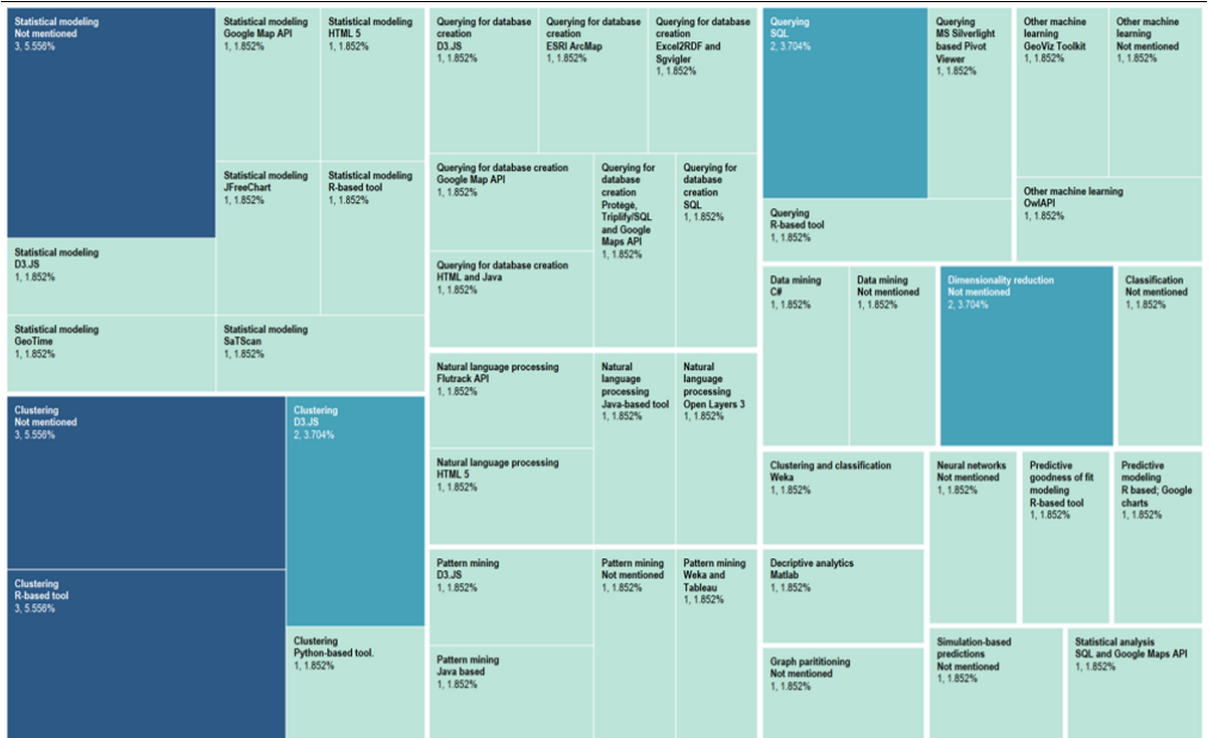
Figure 5. Analytic methods and proportional distribution of tools employed. API: application programming interface; MS: Microsoft; SQL: structured query